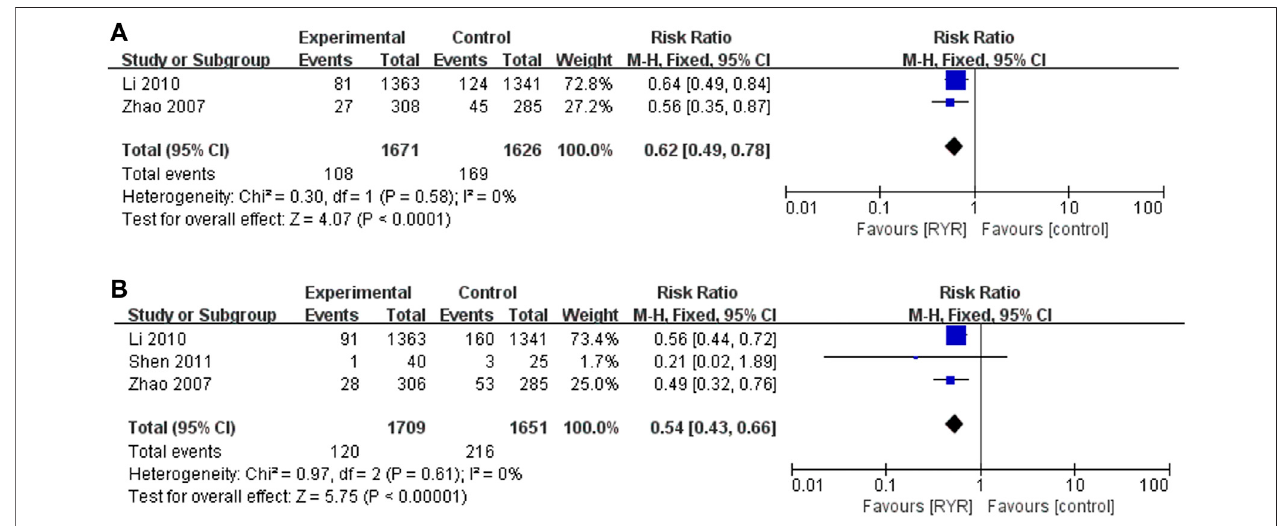
FIGURE 2 | Forest plots of the risk of (A) mortality and (B)